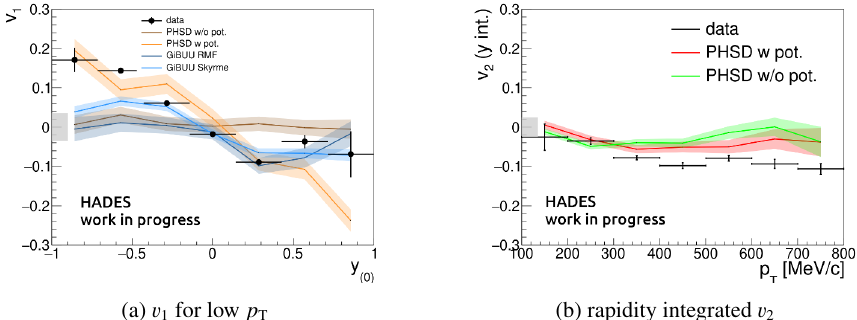
Figure 3: Comparison of model predictions for transverse flow of K + for 20 − 30% most central